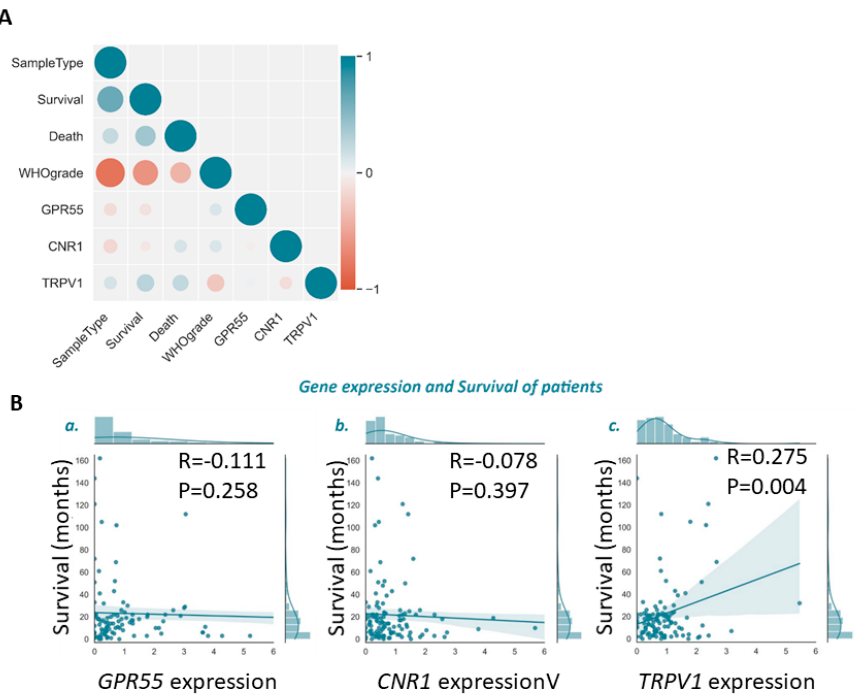
Figure 2. Correlation of cannabinoid receptors with glioma patient survival. ( A ) Graphical represen- tation of the correlation matrix for the correlations between the expression of the receptors GPR55 ( n = 113), CNR1 ( n = 129), and TRPV1 ( n = 116) and glioma sample type and overall glioma patient survival (months). The correlations range from − 1 (red dots) to 1 (blue dots). The closer the values are to 0, the more uncorrelated the variables are. ( B ) Estimation of the regression model between patient survival and the expression of three cannabinoid receptors: GPR55 ( a .; n = 106.), CNR1 ( b .; n = 120), and TRPV1 ( c .; n = 109). R: the correlation coefficient between the analysed variables; p : statistical p -value (considered significant when p < 0.05). Table 1. Significance of correlations in Figure